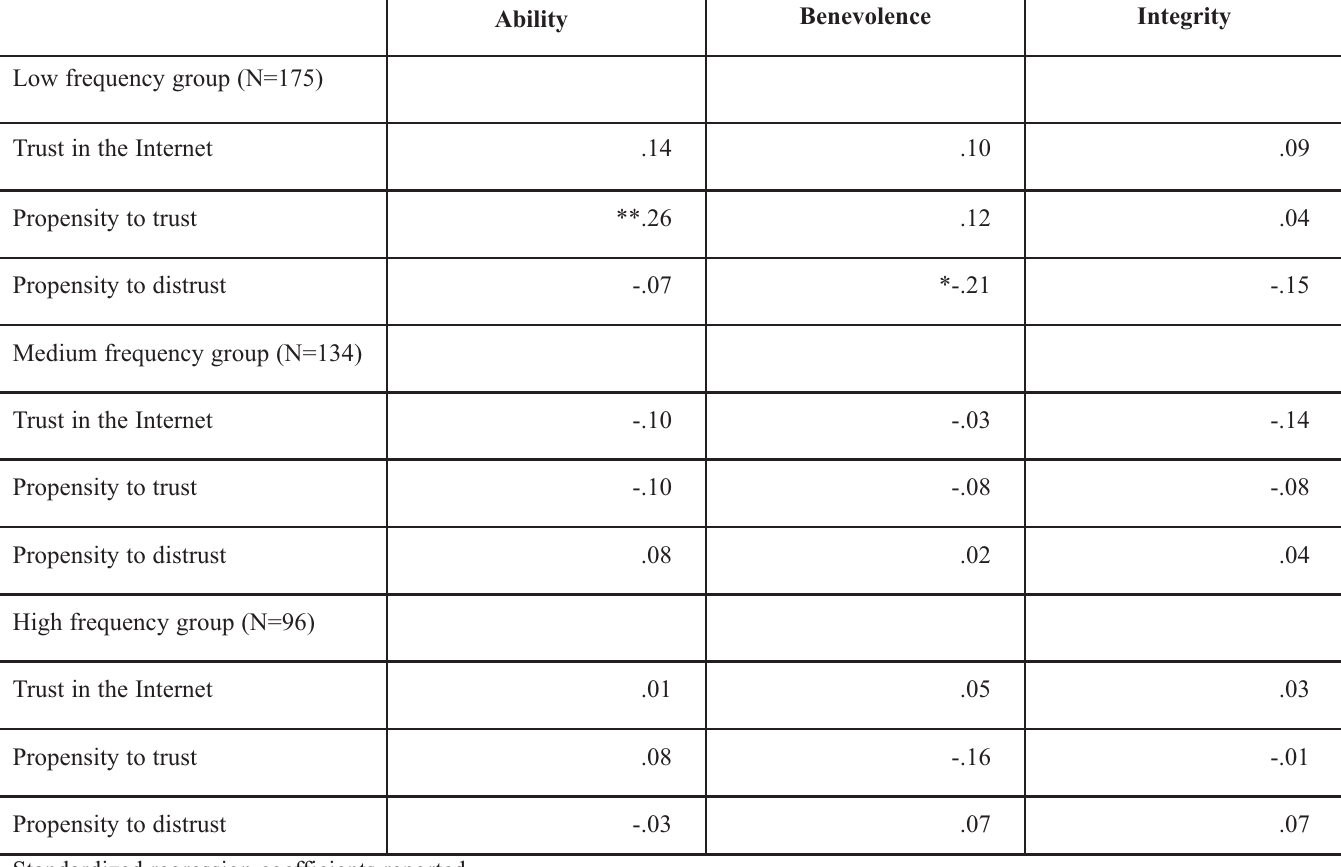
Regression of Propensity to Trust Factors on Perceived Ability, Benevolence, Integrity, and Trustworthiness for Low, Medium, and High Internet Purchase Frequency